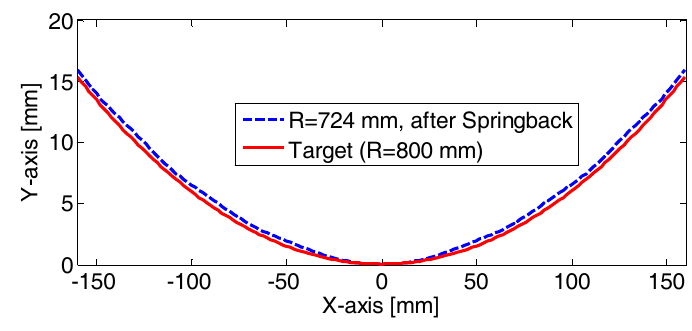
Figure 12. Compensated optimal result.